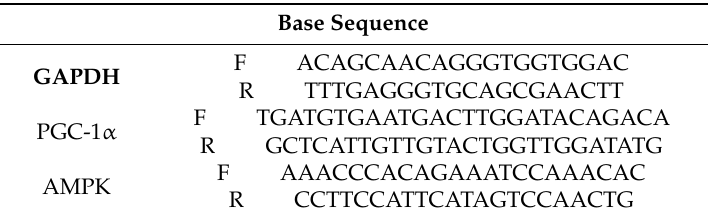
Table 1. RT-PCR base sequence.